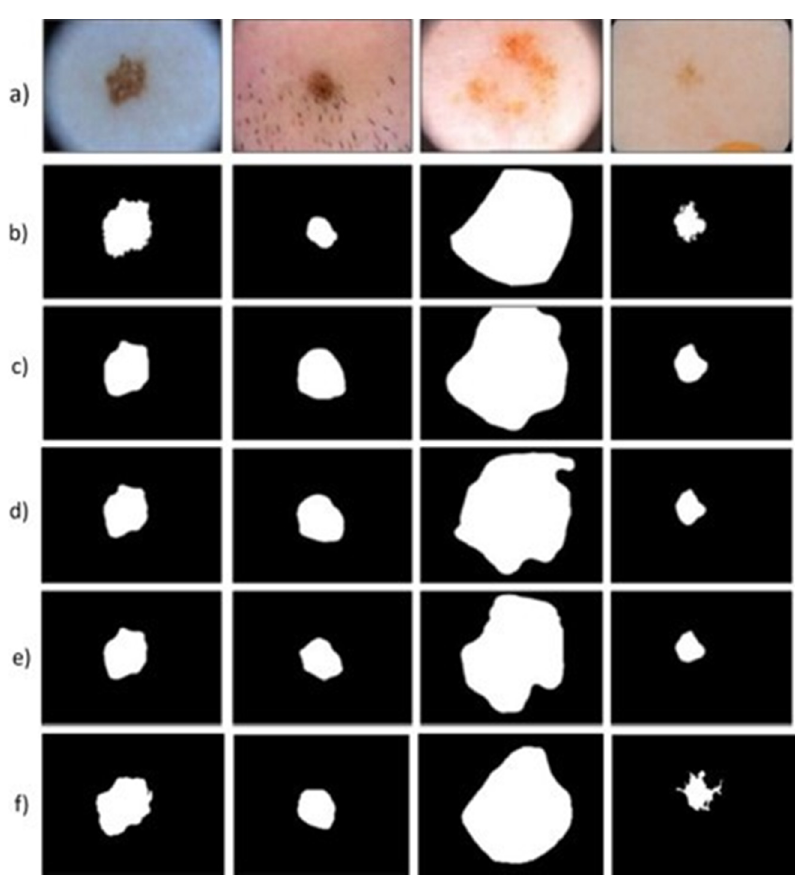
Figure 8. The ablation experiment segmentation diagrams for the input image. ( a ) The initial image taken from the dataset. ( b ) The image’s ground truth; ( c ) Att U-Net + GN + TL; ( d ) Att U-Net + GN + FTL; ( e ) Att U-Net + GN + DL (TL: Tversky Loss; FTL: focal Tversky loss; DL = Dice loss). ( f ) Our RL algorithm results. The segmentation mask boundaries are sharper than the state-of-the-art methods, as shown.